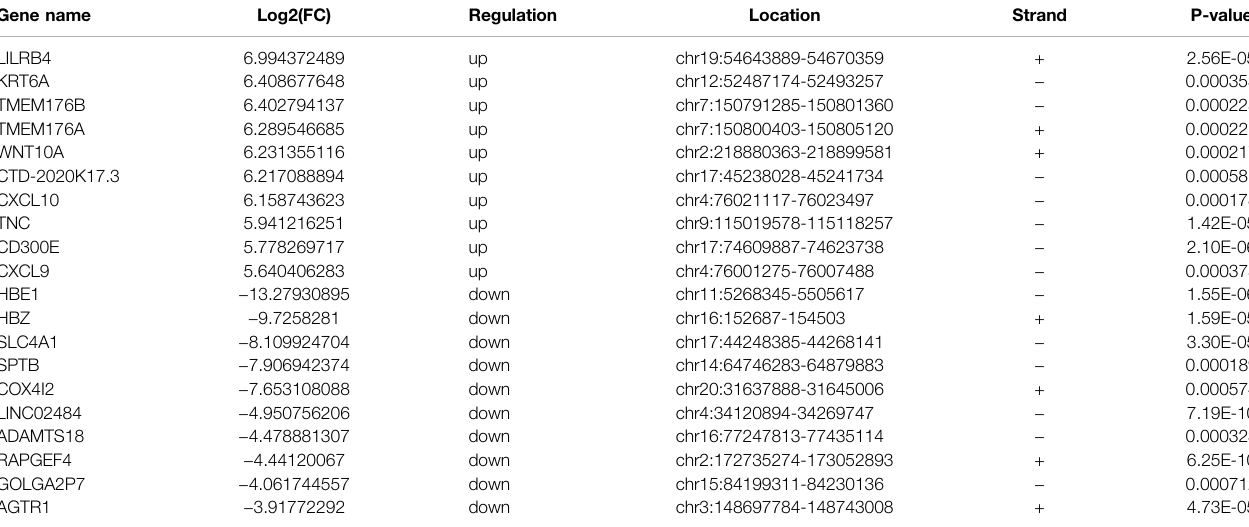
TABLE 2 | The top 20 differentially expressed mRNAs in human villi during spontaneous abortion in the fi rst